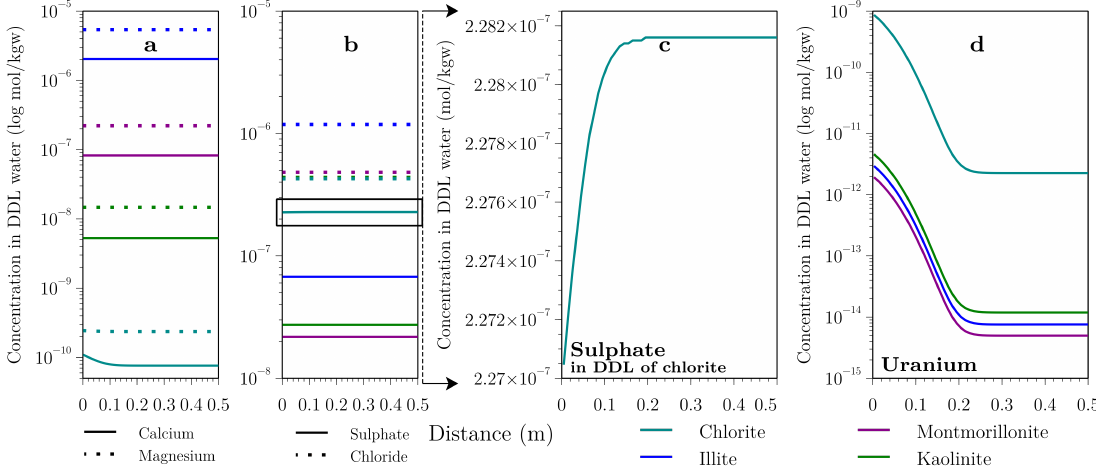
Figure 4. Concentrations of calcium and magnesium ( a ), sulphate and chloride ( b , c ) and uranium ( d ) in the DDL of the clay minerals for the sandy facies after a simulation time of 100years and for a pCO 2 of 10 − 2.2 bar. For better clarity, the concentration of sulphate in the DDL of chlorite is given in c as close-up of ( b